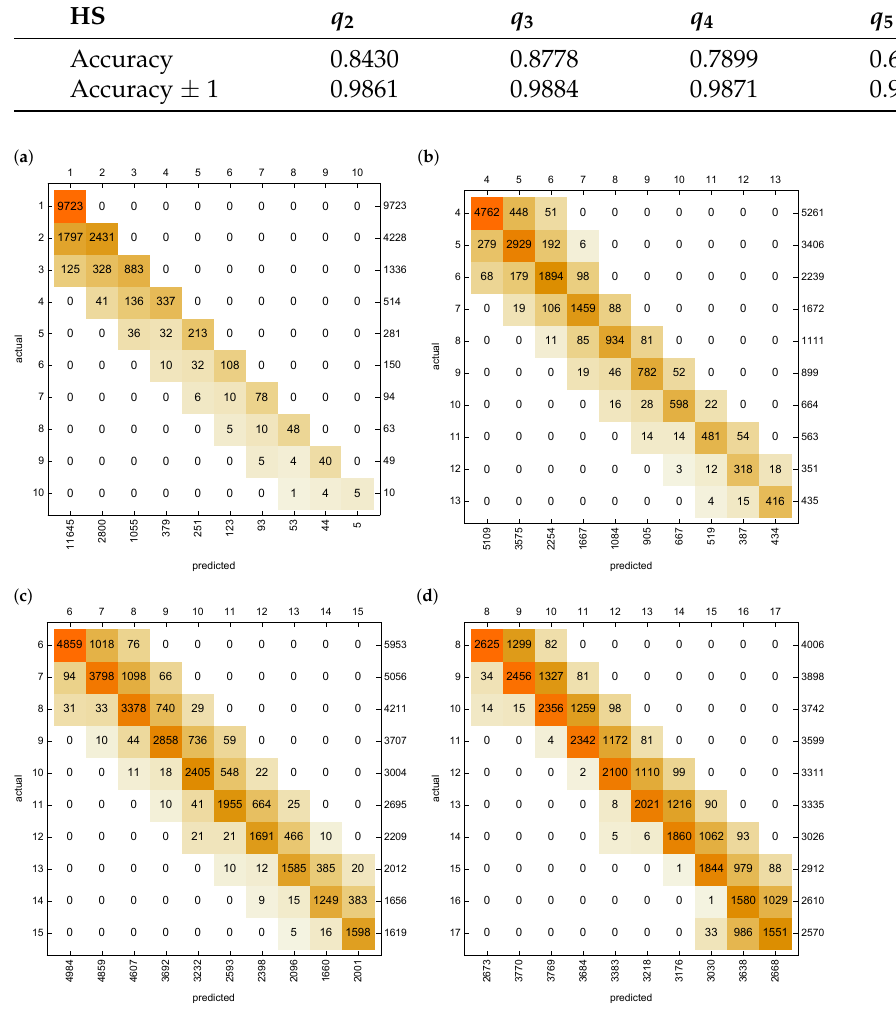
Figure 3. Confusion matrices ( a – d ) for prediction of q 2 , q 3 , q 4 and q 5 using